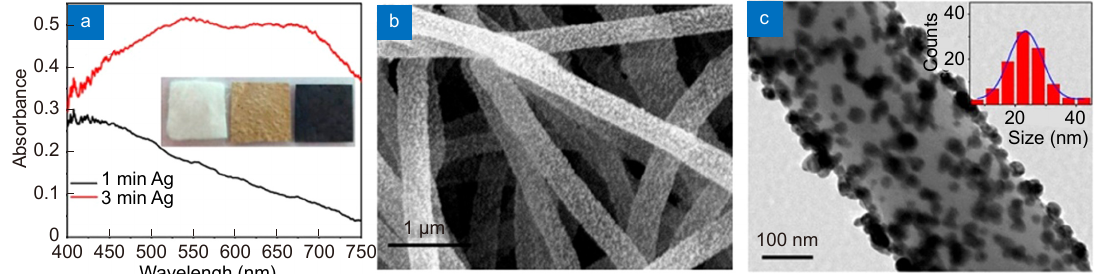
Fig. 9 | ( a ) Reflectance spectra of the ASFPAN nanofibrous membranes with Ag NPs; Photographs of three nanofibrous membranes (PAN, AS- FPAN, and ASFPAN-Ag NPs) are shown in the inset. ( b ) SEM image and ( c ) TEM image of ASFPAN nanofibers (3 min). Inset in (c) shows the size distribution of Ag NPs. 107 , American Chemical Society.